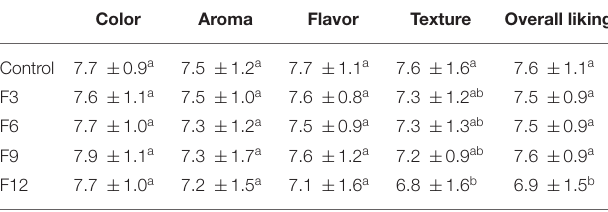
TABLE 2 | Chemical composition (%) of prebiotic burgers. Moisture Protein Fat Ash